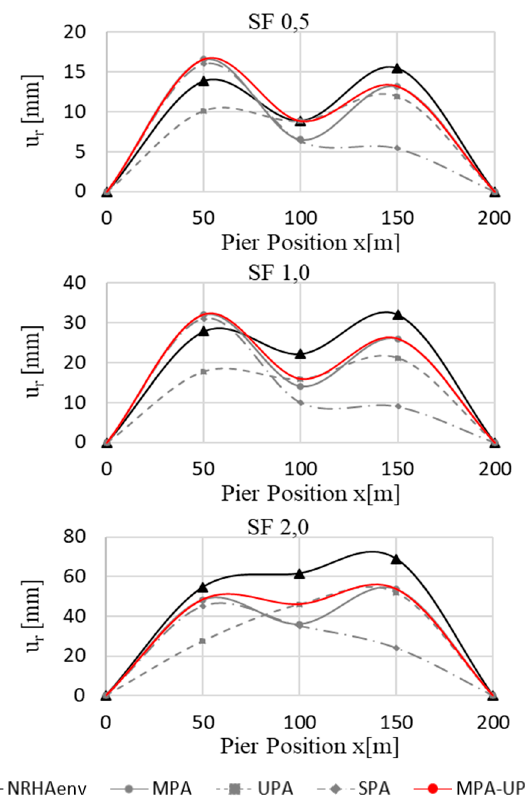
Figure 15. Fault normal: displacements of the deck derived performing NRHA and nonlinear static analysis (scale factor from 0.5 g to 2.0 g).